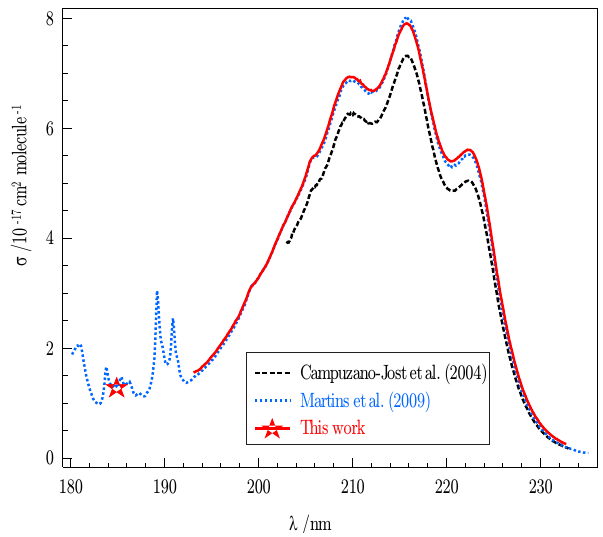
Figure 1. UV absorption spectra for isoprene from this work and from the literature. The red solid line represents data recorded at a resolution of ± 0.4nm; the red star depicts σ isoprene = ( 1 . 28 ± 0 . 02 ) × 10 − 17 cm 2 molecule − 1 at 184.95nm (see Fig. 2) subse- quently used to derive absolute concentrations for kinetic experi- ments. Results from this work agree well with the more extensive, high-resolution dataset from Martins et al. (2009) represented here as a blue dotted